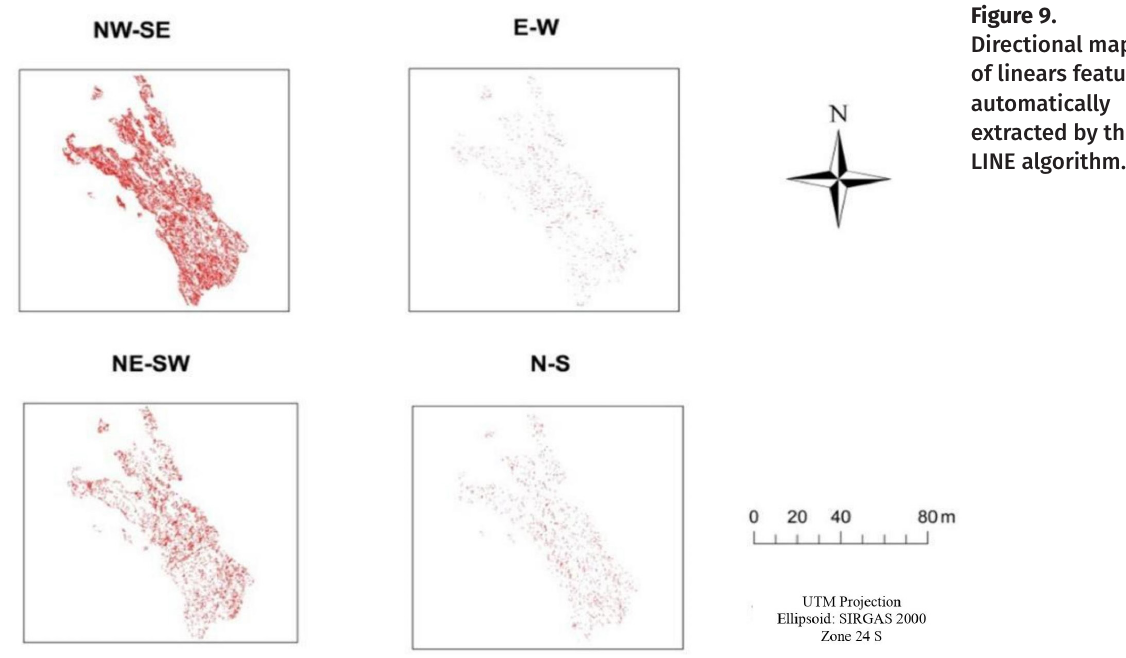
Figure 8. Shaded relief image with azimuth of 135°/elevation 45°, and its lineaments manually